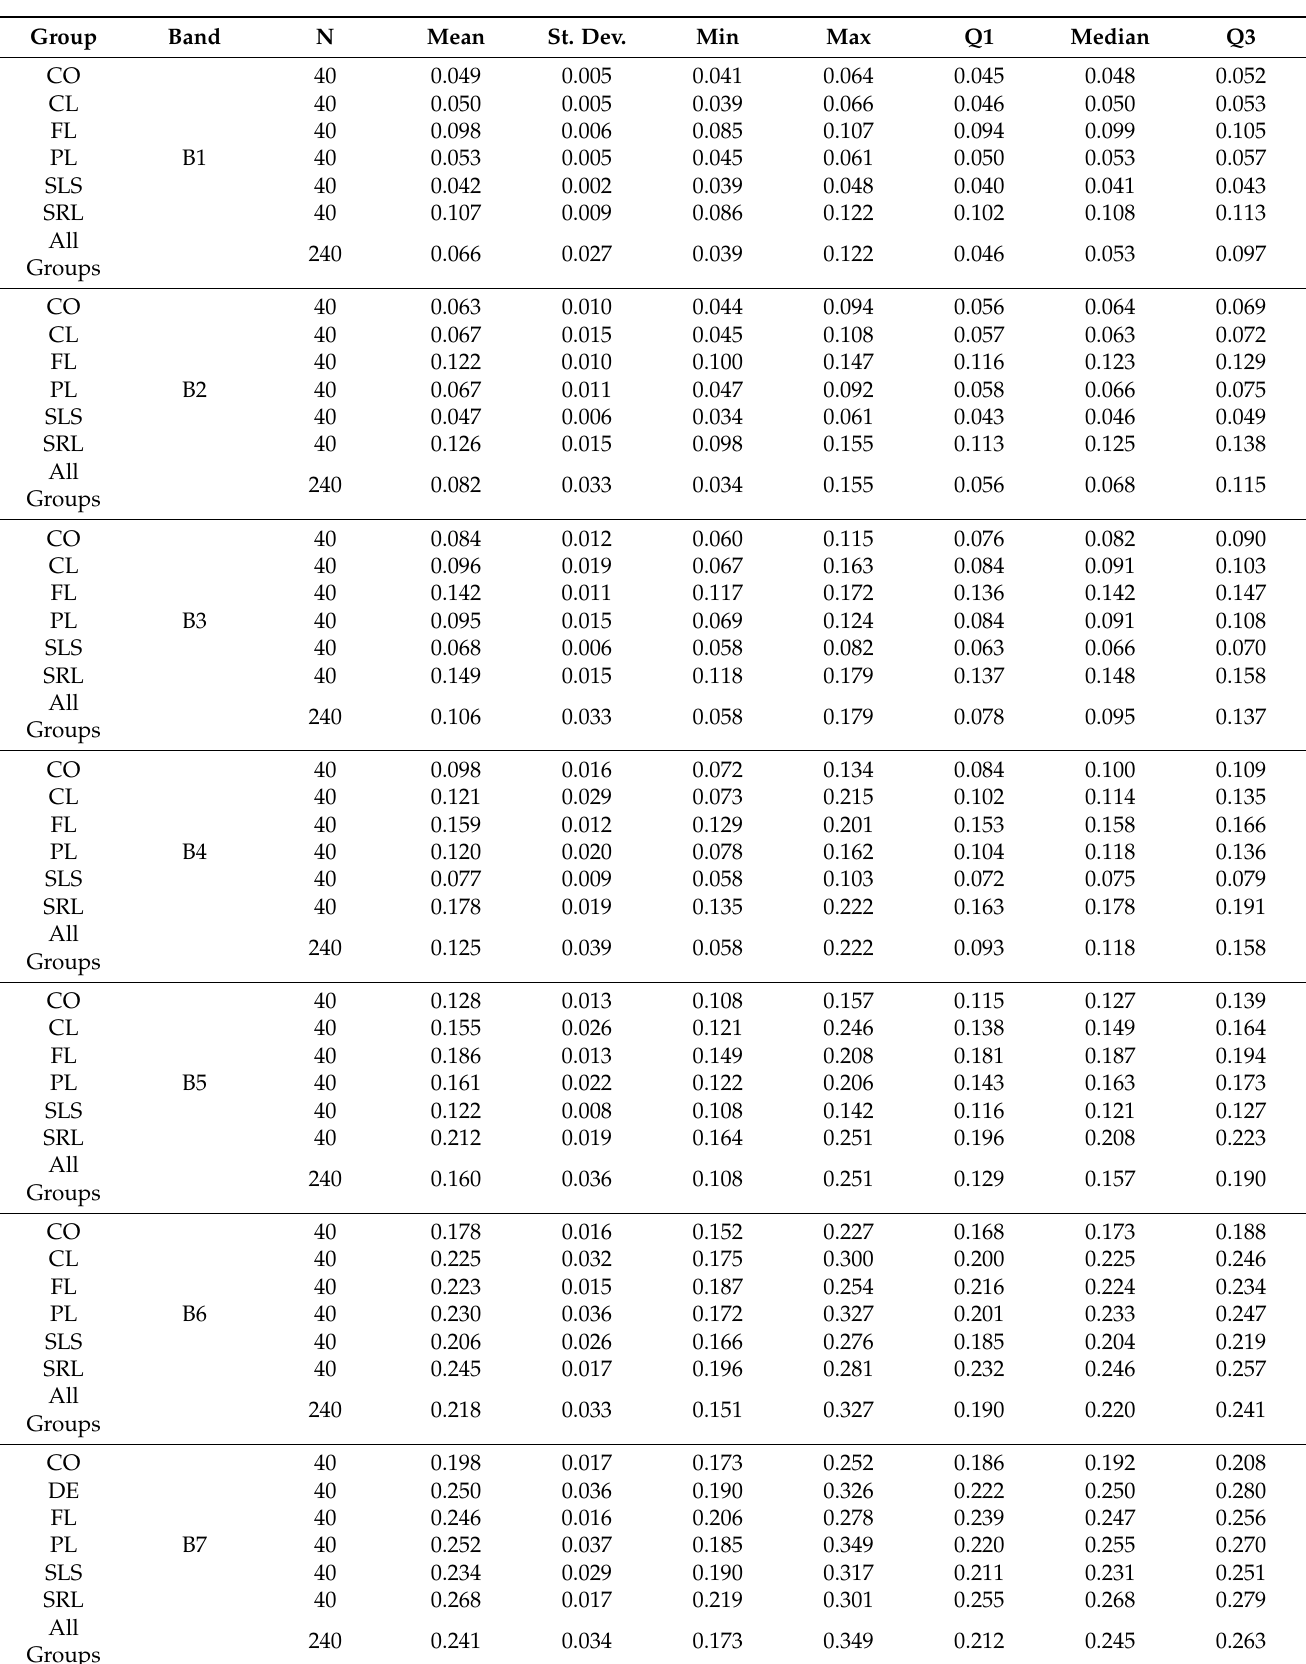
Table 3. Breakdown table of descriptive statistics for each band and lithological